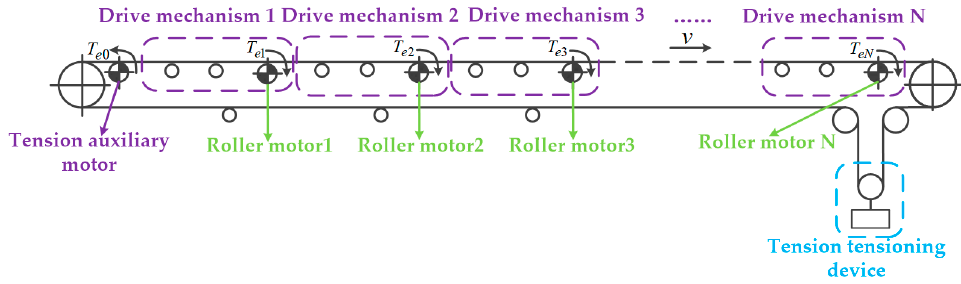
Figure 1. Structure diagram of a distributed permanent magnet direct-drive belt conveyor.